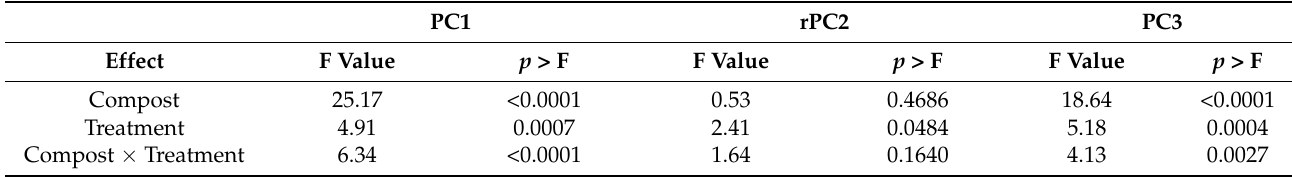
Table 8. Results of the mixed effect model estimation for the